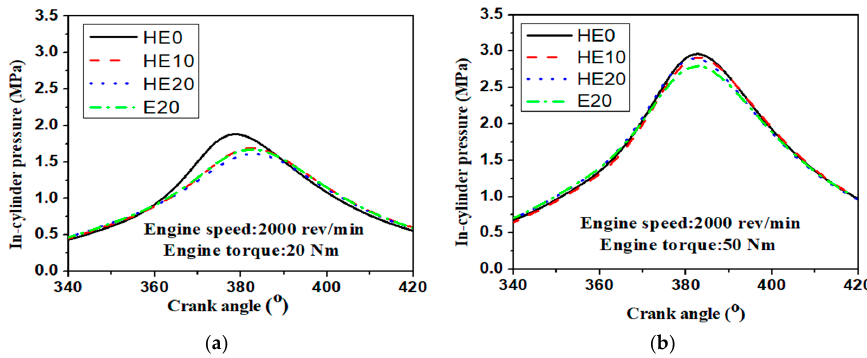
Figure 3. Impact of hydrous ethanol gasoline blends on in-cylinder pressure at an engine speed of 2000 rev/min and engine loads of ( a ) 20 Nm and ( b ) 50 Nm.